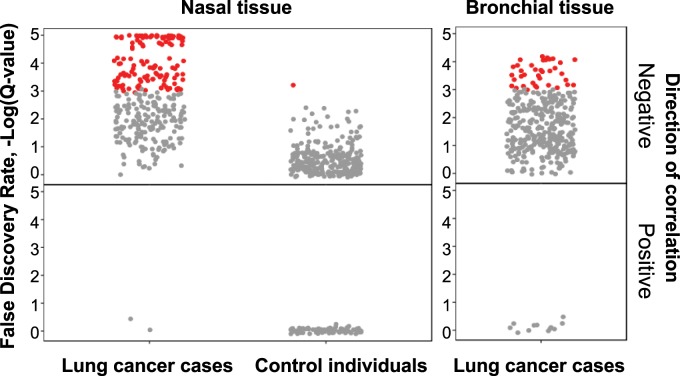
Enrichment of immune system related pathways with low DNA Repair score using gene set enrichment analysis (GSEA). Genes ranked by the RNAseq2 analysis according to their correlation to the DNA Repair score were analyzed by GSEA to identify pathways (using gene ontology terms) that statistically significantly correlate with the DNA Repair score. The analysis was performed separately for case patients and control individuals. This leads to a list of pathways ranked according to their normalized enrichment score, the top 30 of which are shown in Supplementary Table 2 (available online). The figure presents for each tissue and health state all of the 366 immune system–related pathways as found by the GSEA analysis (according to keywords presented in Supplementary Table 2, available online). Each dot represents a pathway, with its y-axis value showing the false discovery rate, -Log(Q-value), for the enrichment score. The pathways are colored according to their false discovery rate values: gray dots Q-Value > 0.001, red dots Q-Value ≤ 0.001. Negatively and positively enriched pathways are shown for nasal and bronchial tissues, in case patients and control individuals, as indicated.